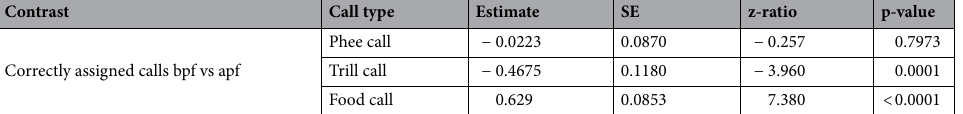
Contrast Call type Estimate SE z-ratio p-value Phee call − Correctly assigned calls bpf vs apf